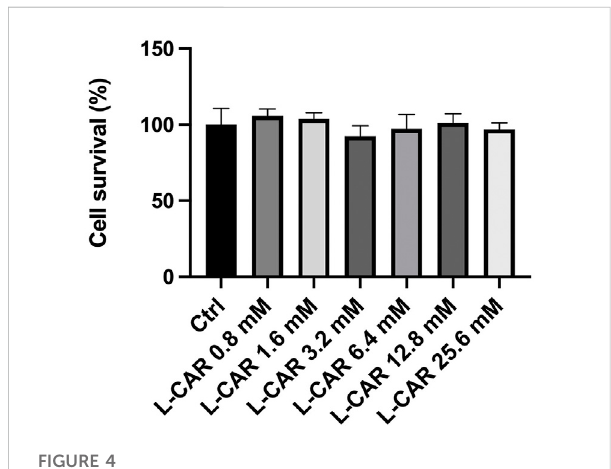
FIGURE 4 Effect of L-carnitine on cell survival in C2C12 myocytes. Differentiated C2C12 myocytes were treated with different concentrationsofL-carnitinefor24 h.Dataarepresentedasthemean +SD ( n =